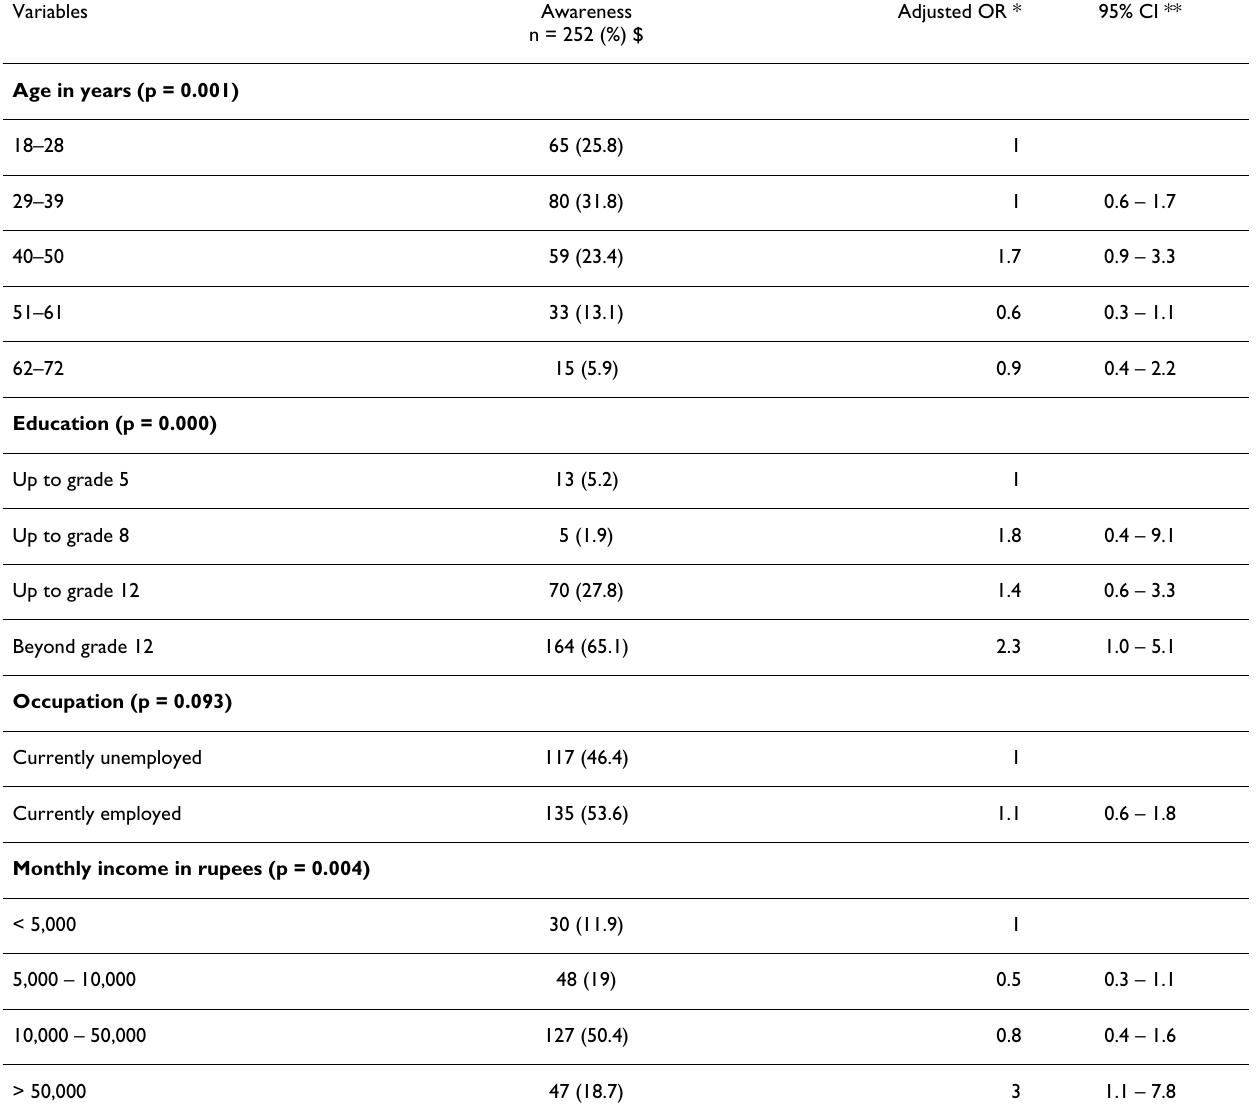
Adjusted OR * 95% CI ** n = 252 (%) $